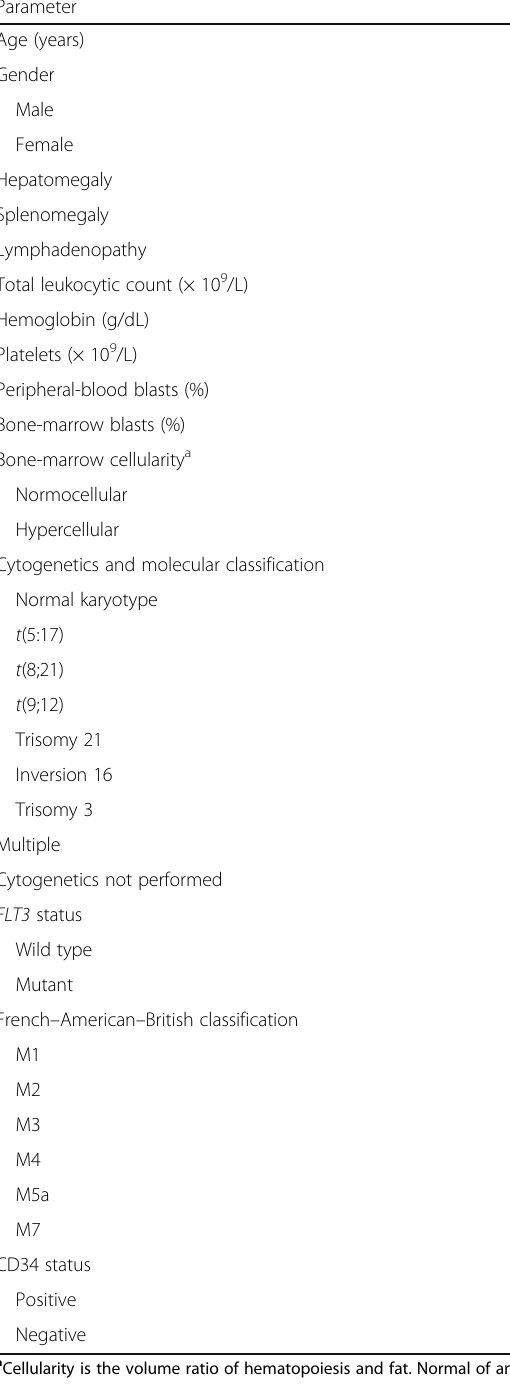
Table 1 Clinical and laboratory characteristics of 60 adults with acute myeloid leukemia